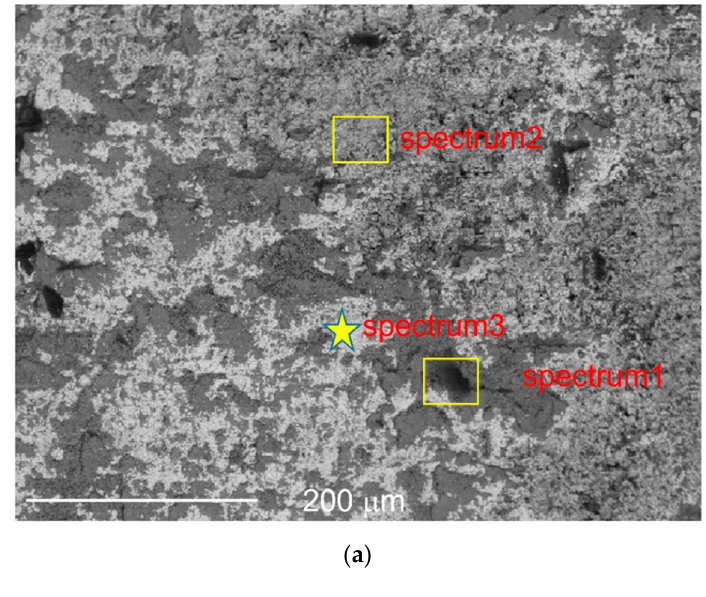
3 C 2 -Ni Cr. Figure 18. SEM micrograph ( a ) and EDS analysis ( b ) of Cr